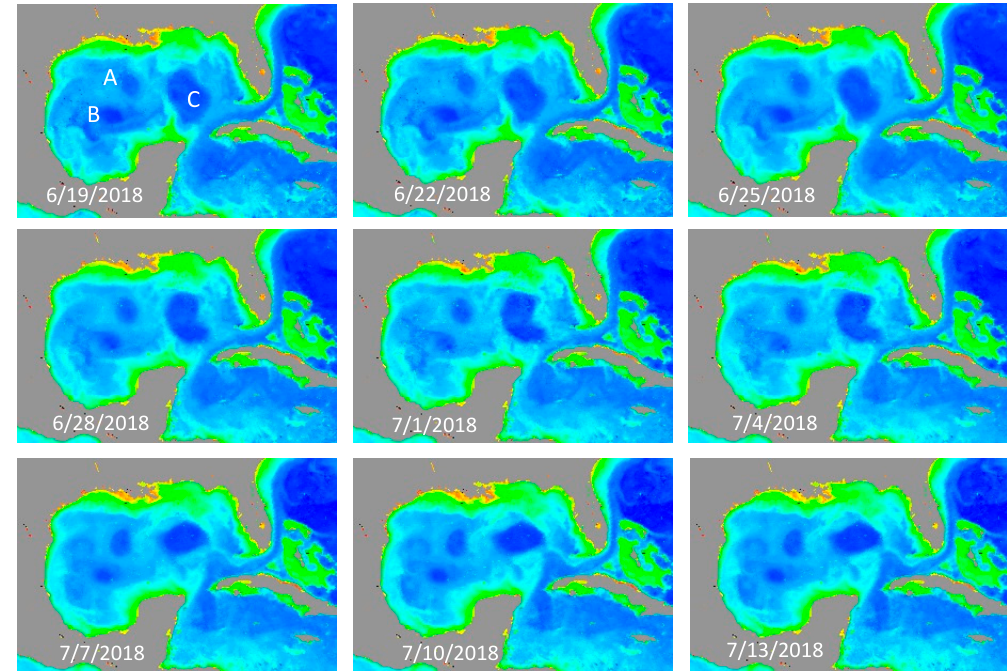
Figure 4. Daily Chl-a images of the Gulf of Mexico (GOM) from 19 June to 13 July 2018 with three loop current eddies ( A , B , and C ) marked on the 19 June 2018 Chl-a image.